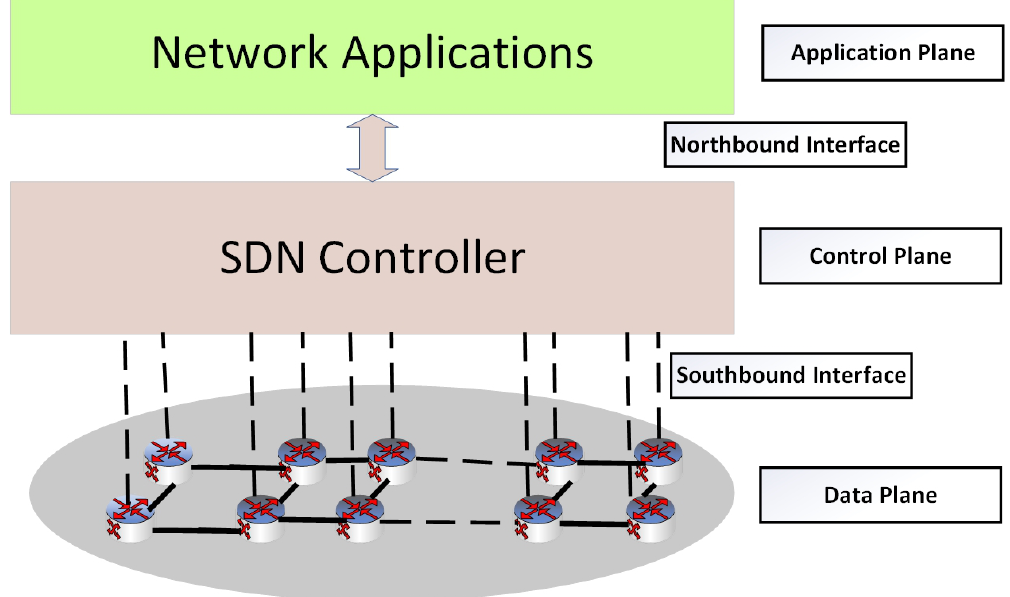
Figure 1. Software defined networking (SDN)